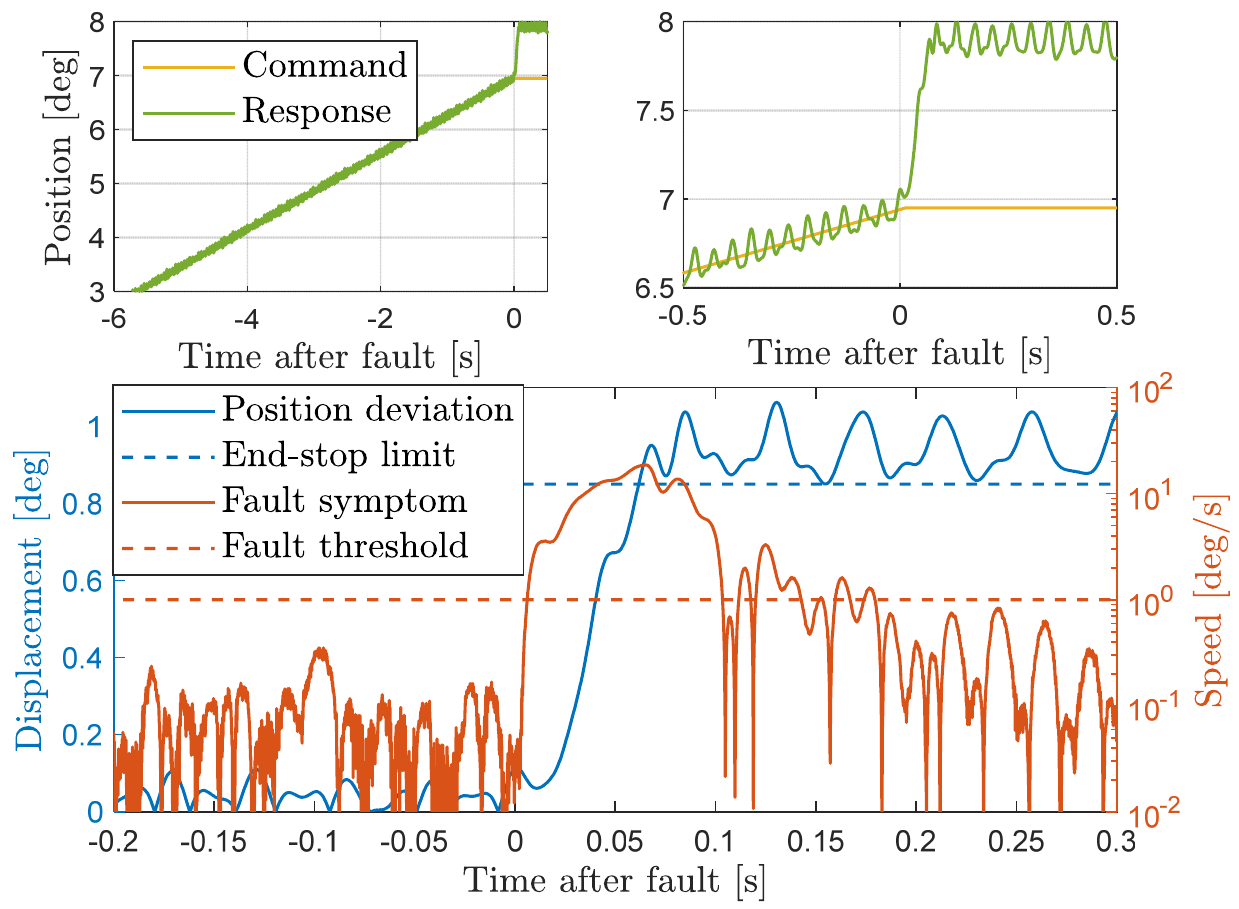
Figure 15. EMA failure transient with a control hardover fault without BEMF damper circuitry: simulation obtained with the experimentally validated model of the actuator ( t FI = 0 s; t FD = 13.4 ms; t FC = 64.4 ms).